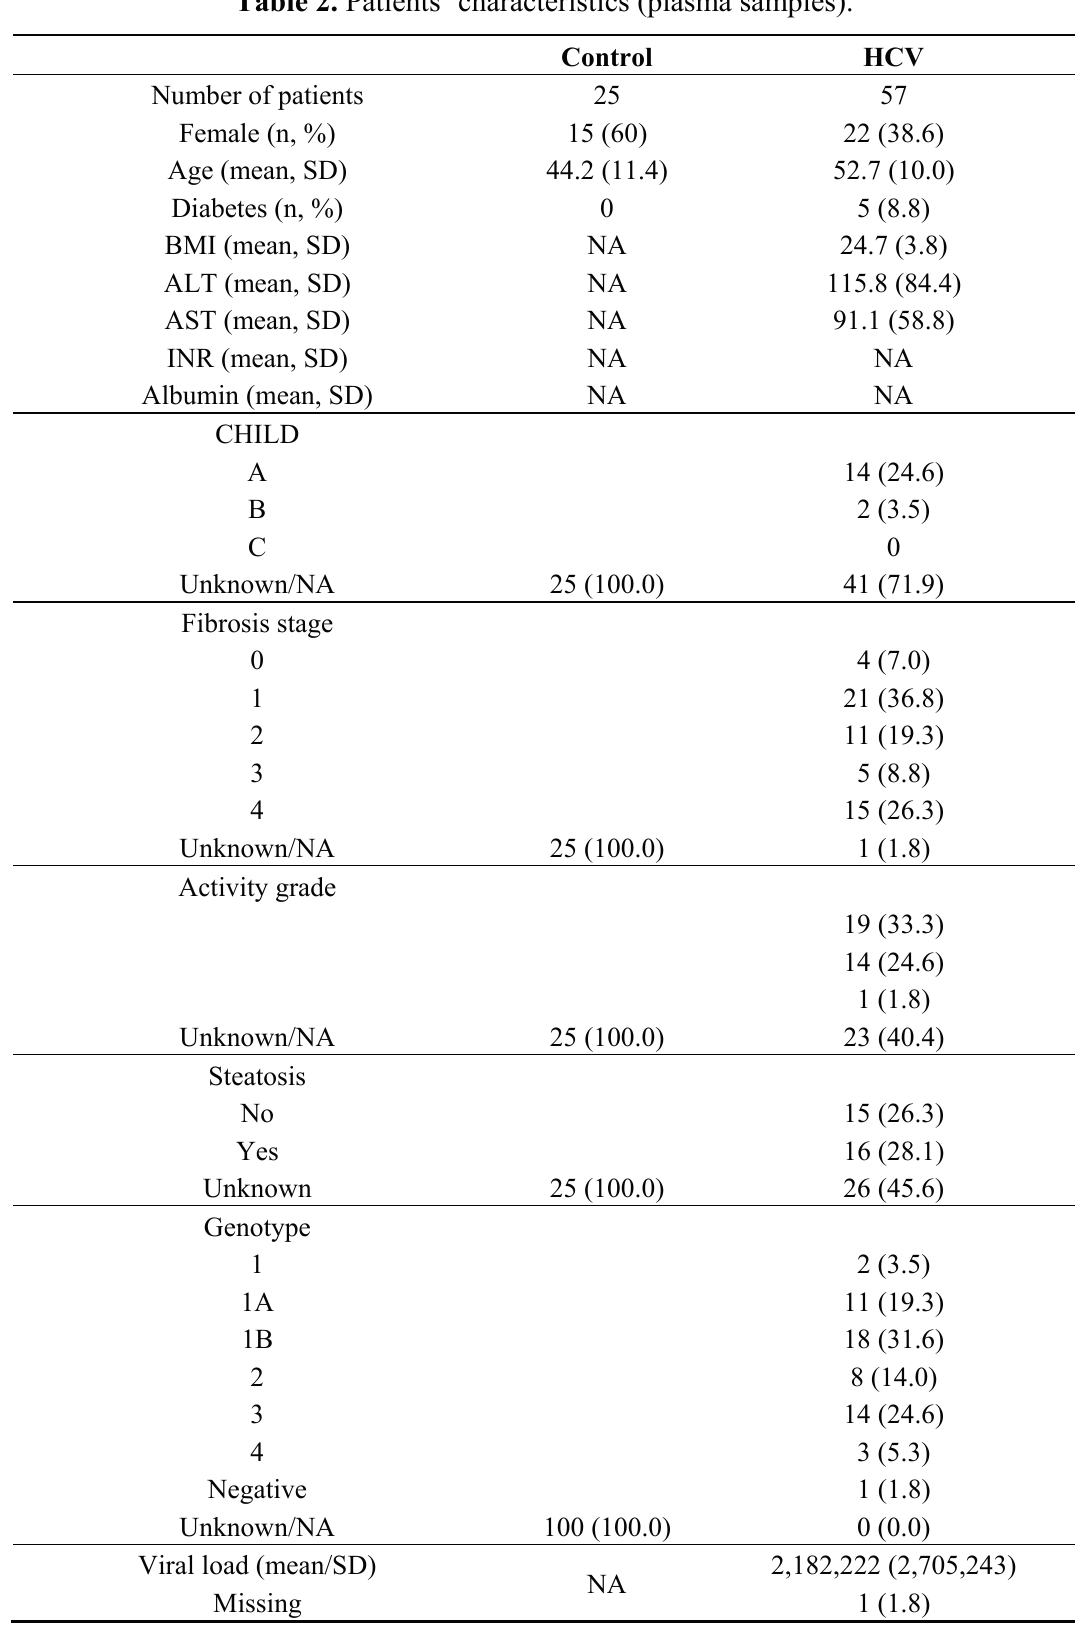
Table 2. Patients’ characteristics (plasma